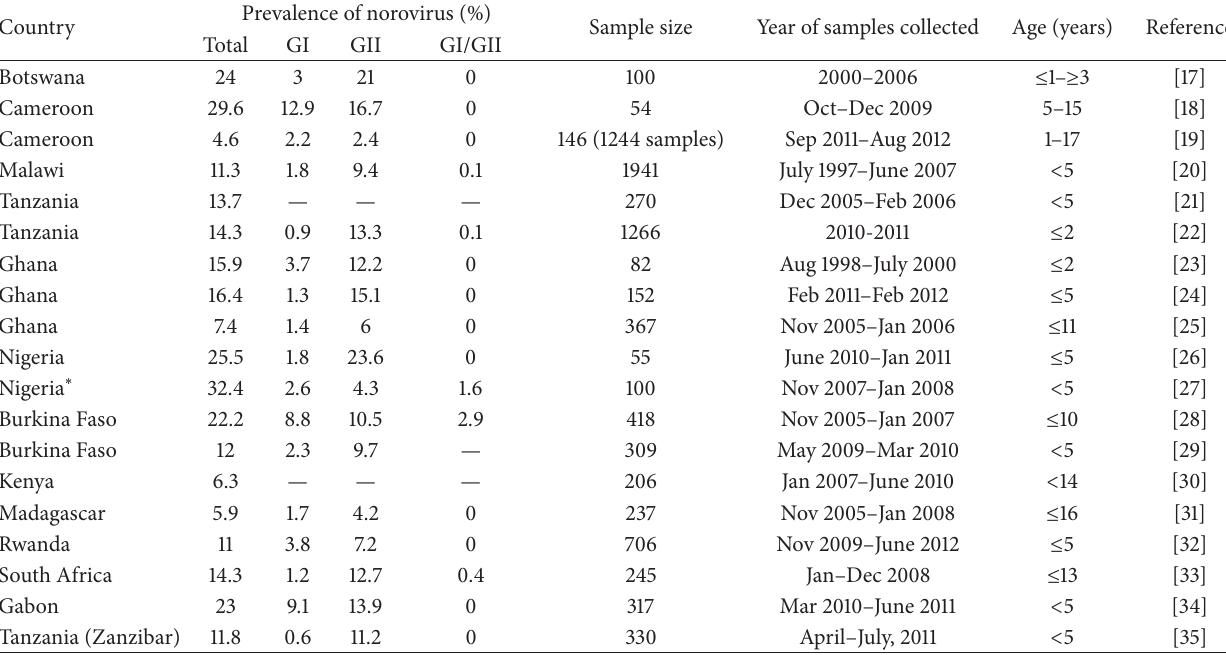
Table 1: Norovirus infections in children in Sub-Saharan